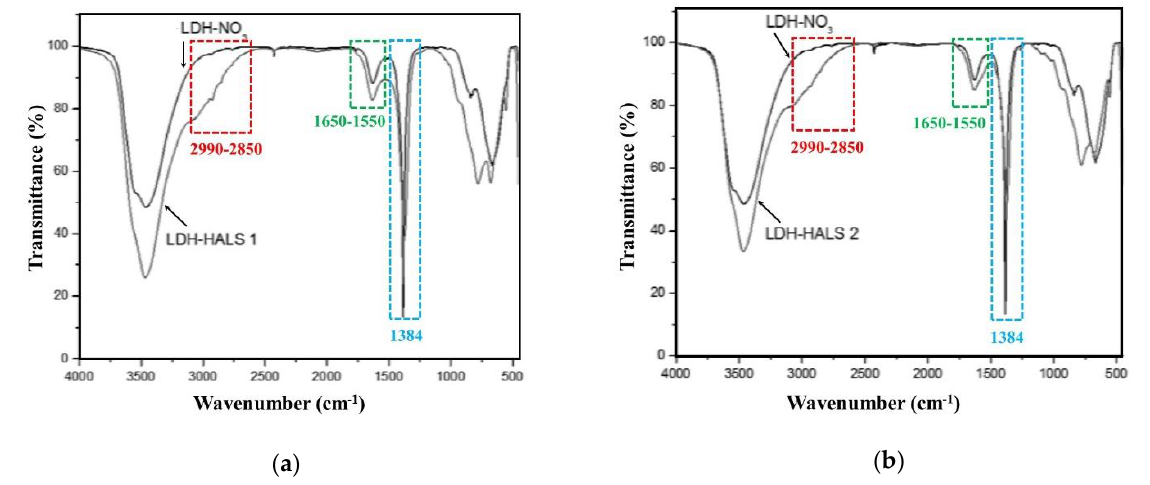
Figure 3. FTIR spectra of ( a ) LDH-HALS1 and ( b ) LDH-HALS2 in comparison to the spectrum of LDH-NO 3.